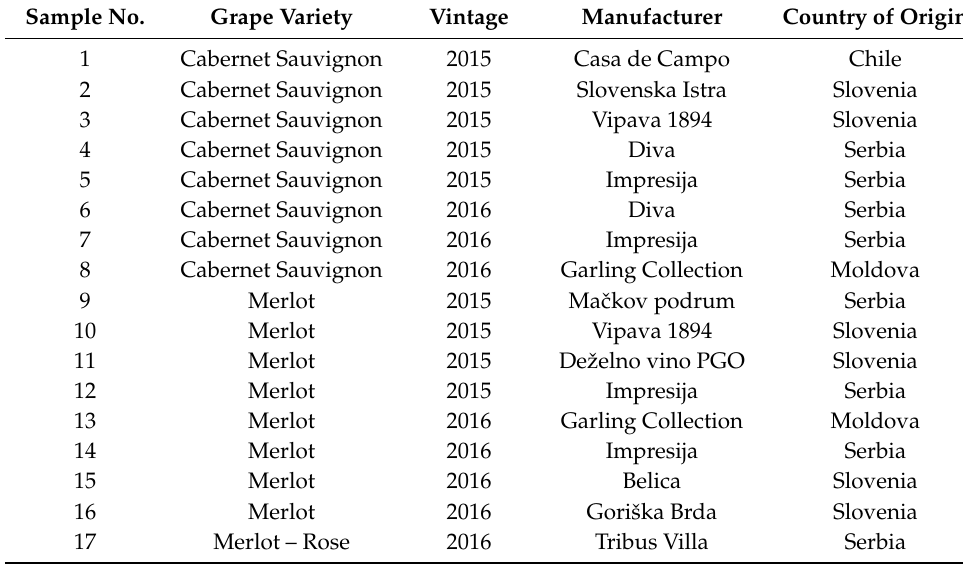
Table 1. Wine samples, grape variety, vintage, manufacturers, and country of origin. Sample